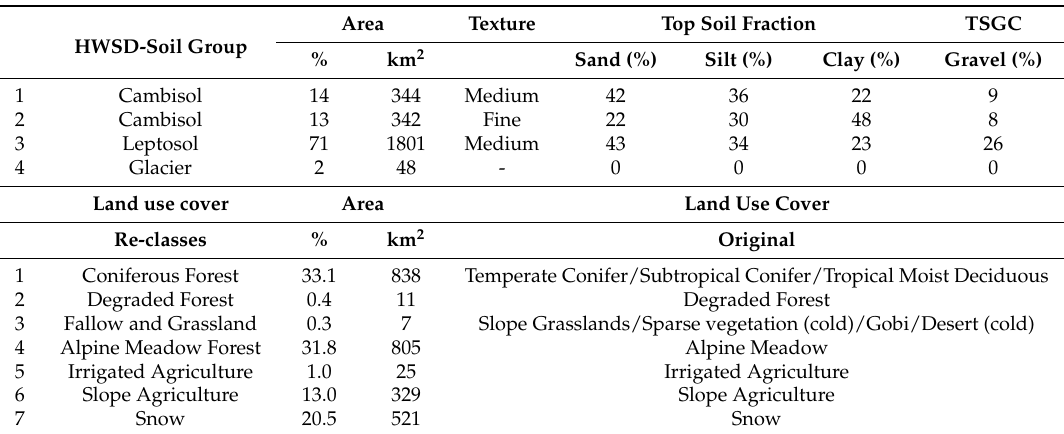
HWSD , Harmonized World Soil Database; TSGC , Top Soil Gravel